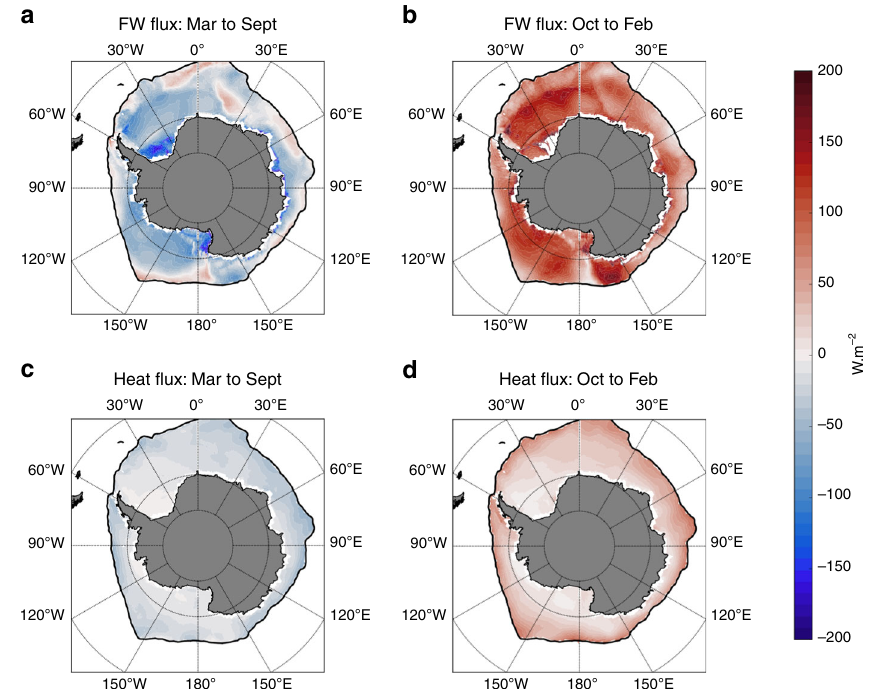
Fig. 2 Surface buoyancy fl uxes in the sea-ice sector. Winter ( a , c ) and summer ( b , d ) surface buoyancy fl uxes derived from an observation-based mixed- layer buoyancy budget, and decomposed into surface freshwater fl ux ( a , b ) and surface heat fl ux ( c , d ). Units are equivalent W m − 2 . The positive values indicate a buoyancy gain into the mixed layer, and the negative values indicate a buoyancy loss into the mixed